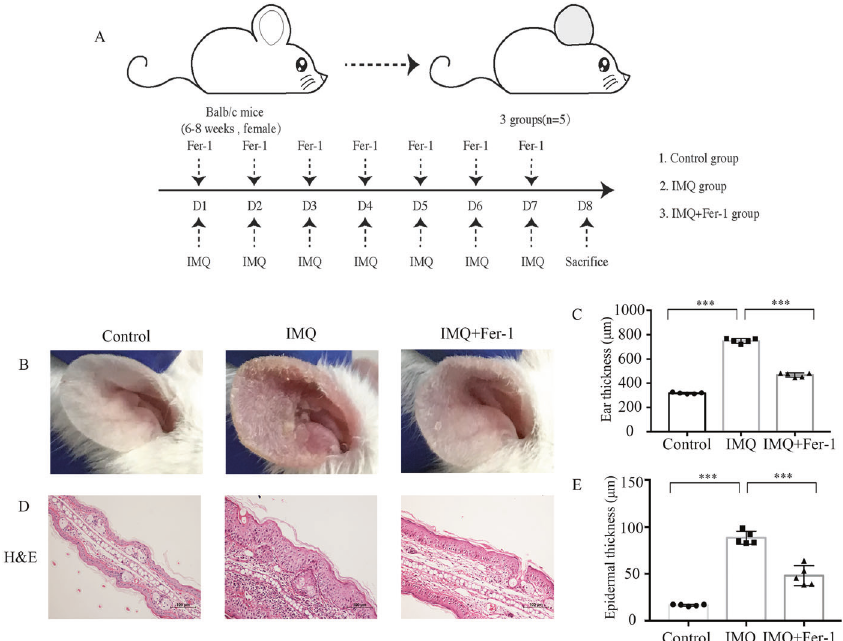
Fig. 5 Fer-1 treatment attenuates IMQ-induced psoriasis-like dermatitis of mice. Mice were topical administered 5 mg IMQ cream or control cream on mouse ears for 7 consecutive days. An equal volume of Fer-1 (0.8 mg/kg/day) or 10% DMSO (50 μ l) were painted on mouse ears 30 min before IMQ application. A Schematic representation of the animal experiments for the Control, IMQ, and IMQ + Fer-1 groups ( n = 5). B Gross photograph of ears at day 8. C Ear thickness on day 8. D Hematoxylin and eosin staining of ear sections on day 8. Scale bar, 100 μ m. E The thickness of the epidermis in ear sections was calculated using ImageJ software. Values were presented as the mean ± standard error ( n = 5). *** p < 0.001. Independent experiments were repeated three times. IMQ imiquimod, Fer-1 ferrostatin-1. In our research, a positive correlation was observed between lipid oxidation and the Th22/Th17 pathway at a single-cell level. To further elucidate the molecular mechanism, we assessed the changes in erastin-stimulated keratinocytes and IMQ- treated mice ear. There